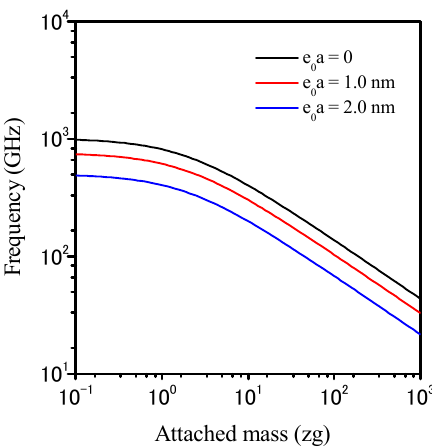
Figure 2. Variation of the resonant frequency in SLGSs as a function of attached mass for different nonlocal parameter ( (cid:1838)